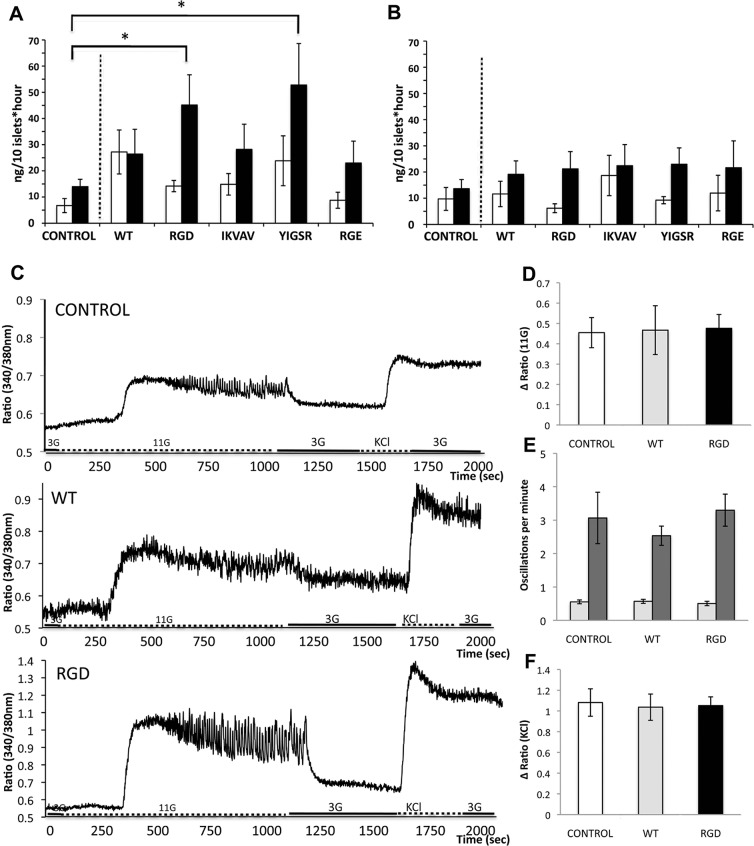
Mouse pancreatic islets are maintained functional when adhered to silk foam.Insulin release (ng/10 islets*hour) from adhered islets after 2 days (A) and 5 days (B) in culture on silk matrices (WT, RGD, IKVAV, YIGSR and RGE), compared to non-adhered islets in control wells. Insulin released after low glucose concentration (3mM) is shown in white bars and insulin released after stimulating glucose concentration (16.7mM) is shown in black bars. At day 2, adhered islets on RGD and YIGSR released more insulin per islet after glucose stimulation compared to control islets (n = 6, triplicates *p≤0.05). (C) Representative pattern of F340/F380 traces due to glucose and KCl induced changes in [Ca2+]i in single mouse islets cultured for 1–2 days on WT, RGD or free floating. (D) Mean value of increase in ratio due to stimulation by 11 mM glucose. (E) Mean value of islet oscillations per minute for slow (light gray) and fast (dark gray) oscillations in [Ca2+]i after high glucose stimuli. (F) Mean value of increase in ratio due to stimulation by 25 mM KCl. (>17 islets from each condition).